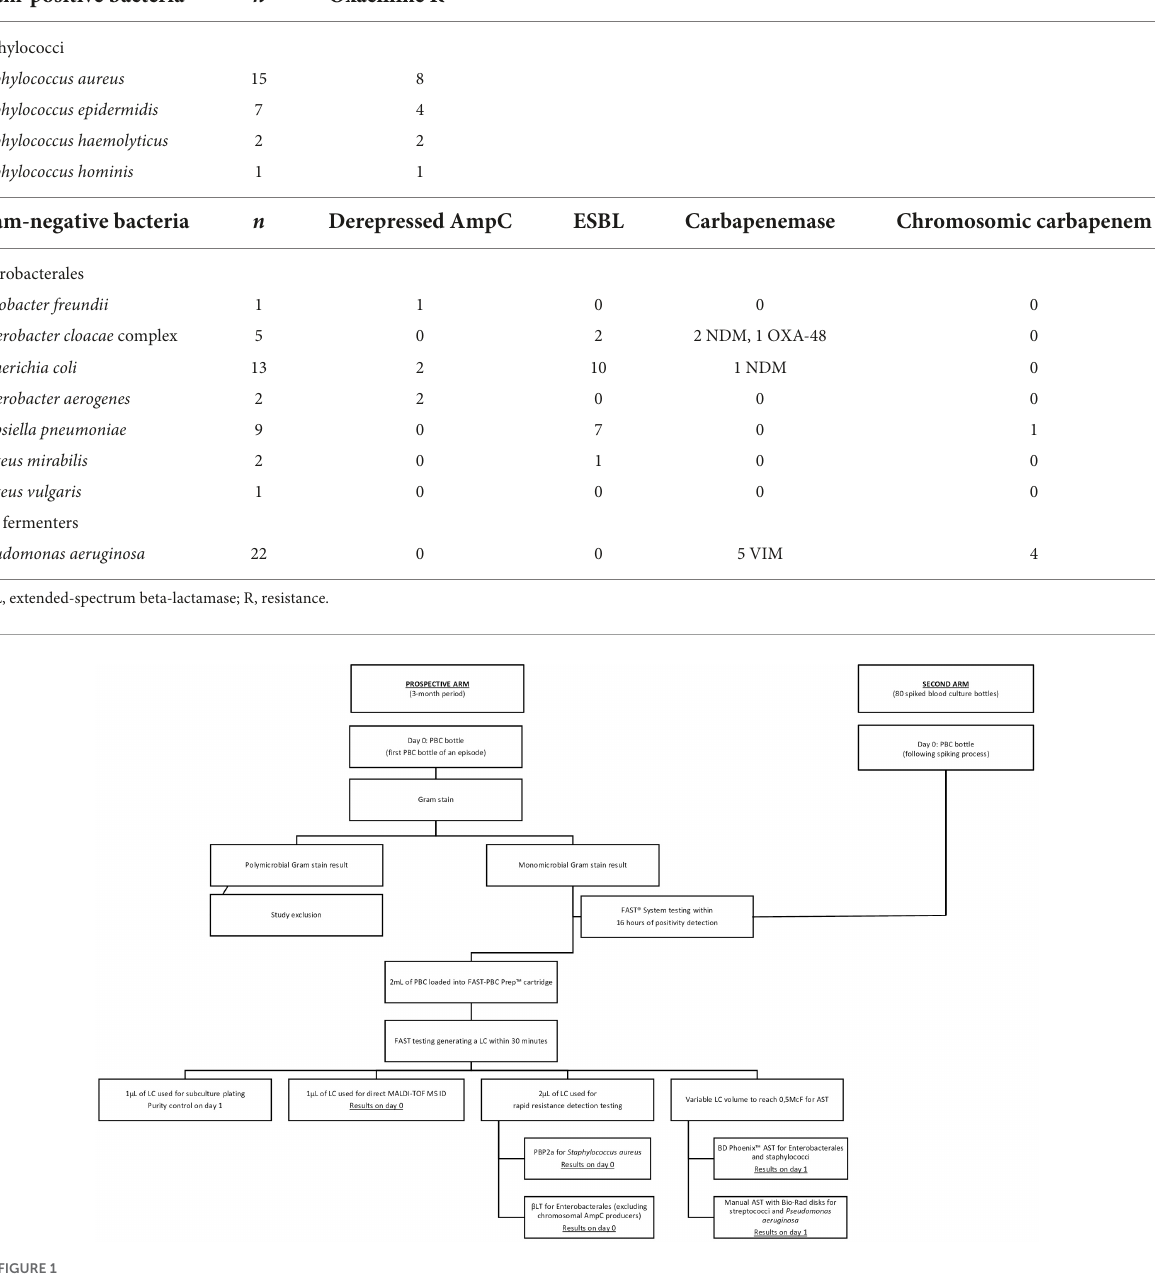
TABLE 1 Microorganisms and resistance profiles selected for FAST TM System testing evaluation in the second arm of the study. Gram-positive bacteria n Oxacilline R Staphylococci